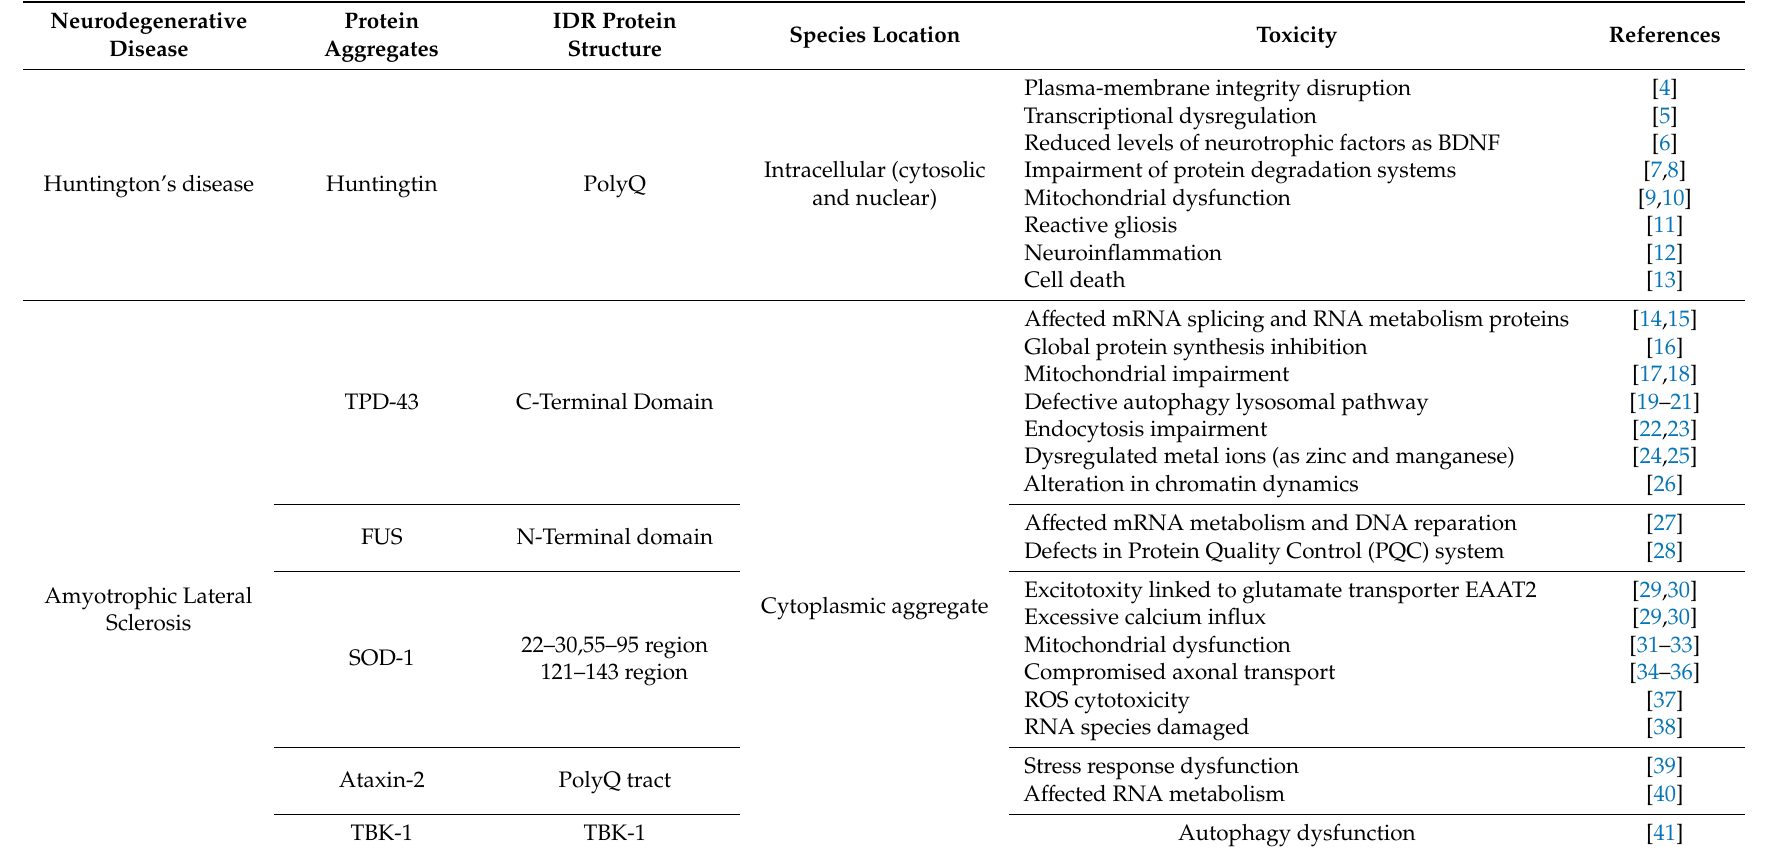
Table 1. Proteotoxicity hallmarks across neurodegenerative